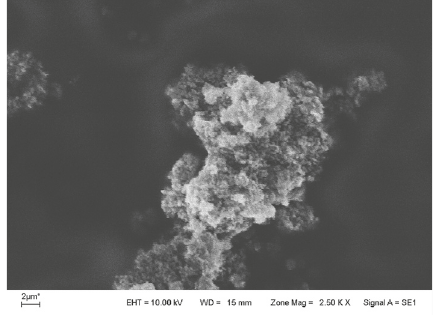
Figure 6: SEM image of the recovered